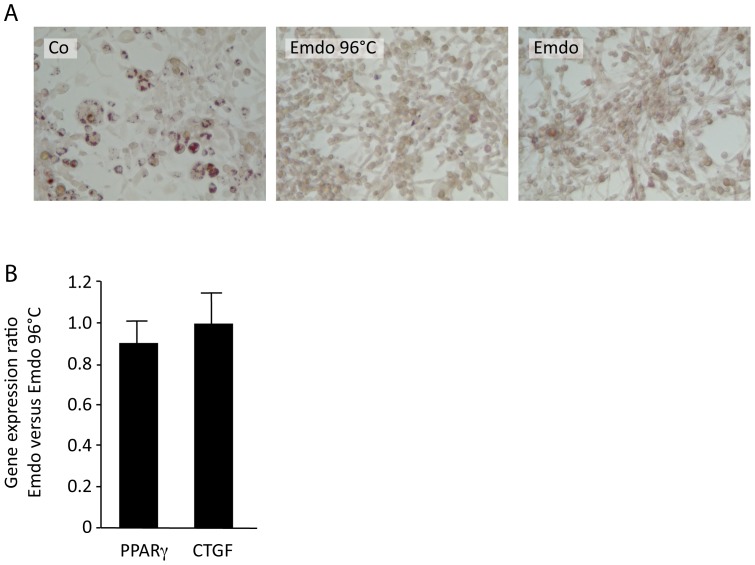
Emdogain® after heating at 96°C maintains the ability to activate TGF-β signaling.(A) The 3T3-L1 murine preadipocytes were exposed to Emdogain® (100 µg/ml) or Emdogain® previously heated up to 96°C within a basal adipogenesis-inducing medium containing rosiglitazone and indomethacin for 5 days and lipid staining was performed. (B) 3T3-L1 cells were also exposed to normal or heat-treated Emdogain® for 18 hours in serum-free medium before the expression of PPARγ and CTGF were determined.